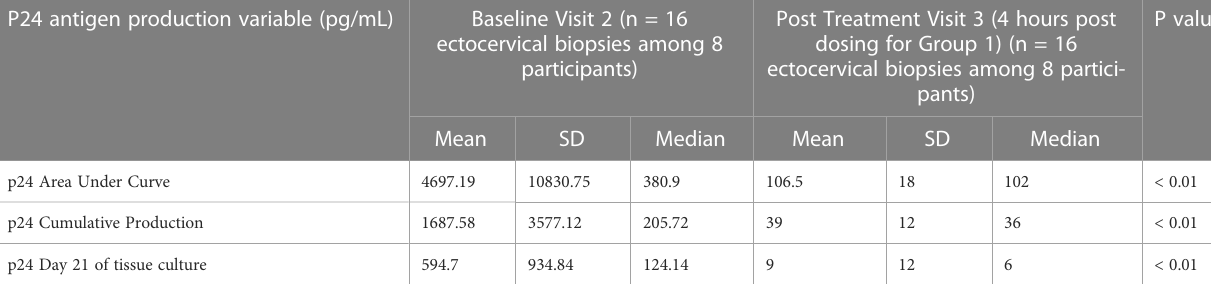
TABLE 5 Ectocervical p24 antigen production after ex vivo HIV infection at baseline and 4 hours post dosing. P24 antigen production variable (pg/mL)